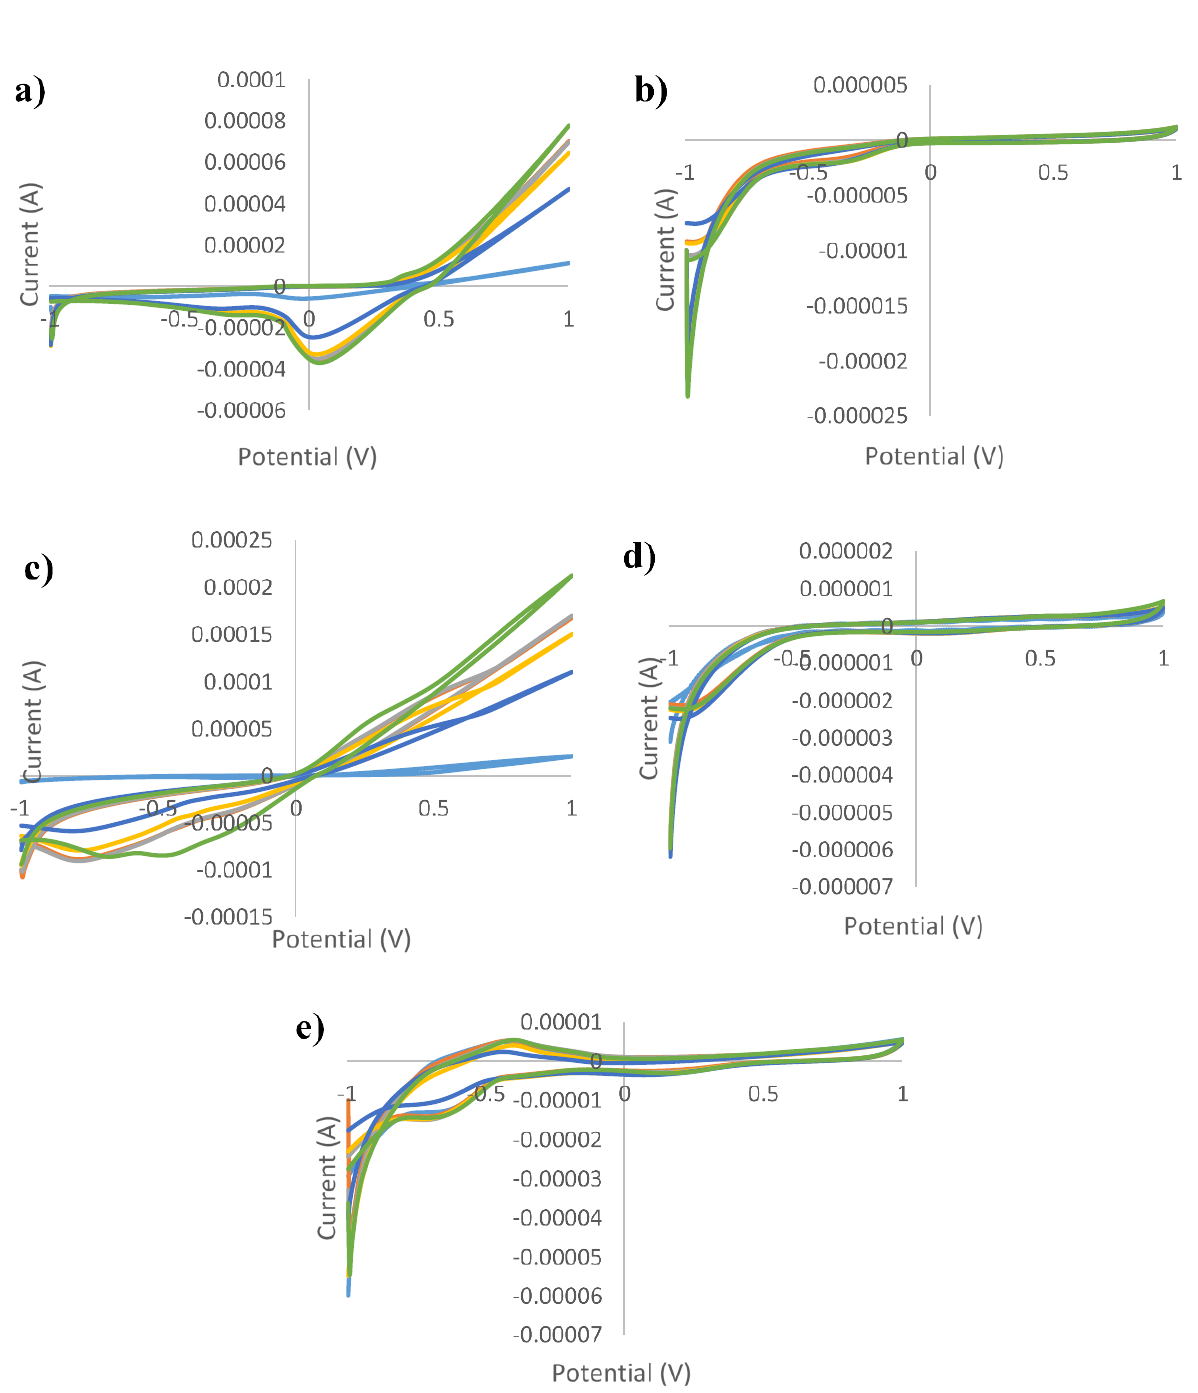
Figure 1. Cyclic voltammograms of authentic and adulterated (with agave syrup) tilia honey solutions for: ( a ) silver electrode; ( b ) gold electrode; ( c ) copper electrode; ( d ) glass electrode; ( e ) platinum electrode and green line—authentic honey; light blue line—agave syrup; red line—honey adulteration 5%; gray line—honey adulteration 10%; orange line— honey adulteration 20%; dark blue—honey adulteration 50%.